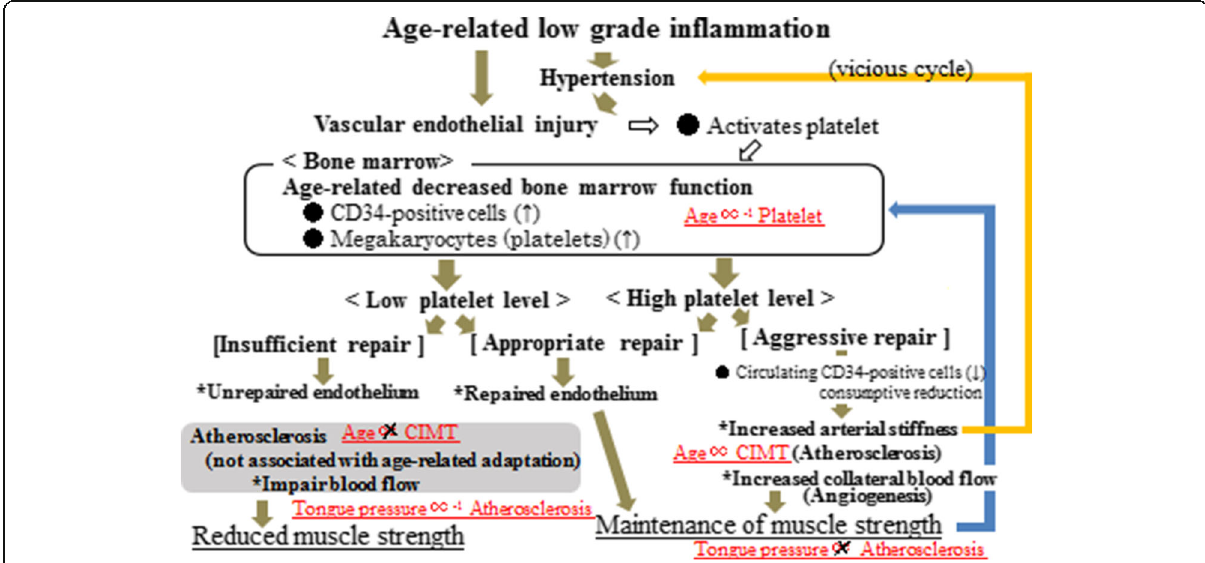
Fig. 2 Possible mechanism underlying the association between tongue pressure and atherosclerosis. Relations in red were observed in the present analysis. CIMT: carotid intima-media